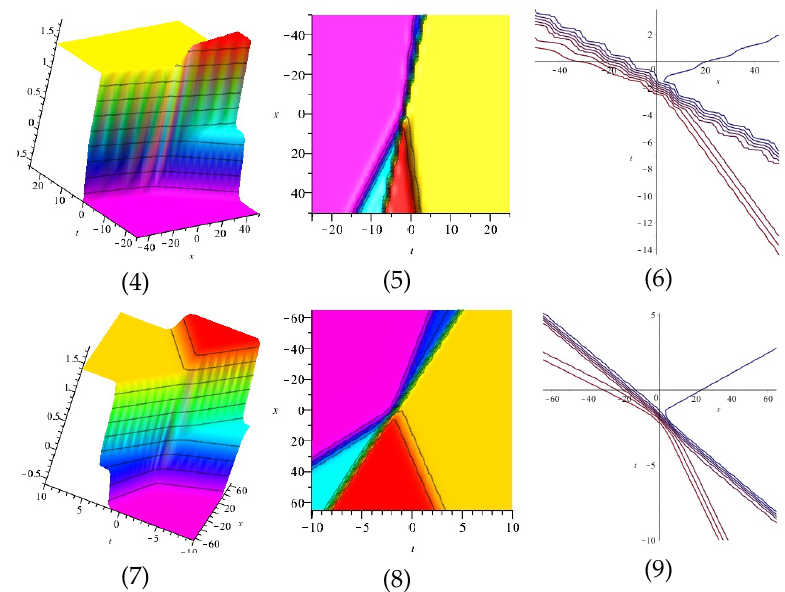
Figure 8. The 3D and 2D with the diagram of u 3,4 , in three different domains, for P 12 = 3.50, A 1 = − 3, A 2 = − 5, A 3 = 7, S 1 = 0.20, S 2 = 0.70, and S 3 = − 0.30. ( 2 ) , ( 5 ) and ( 8 ) display the z − axis orientation and ( 3 ) , ( 6 ) and ( 9 ) are contour